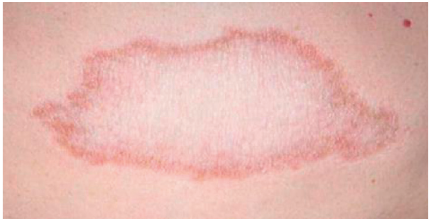
Figure 2: Tuberculoid leprosy: lesion with a single, stable, hairless plaque, and well-defined borders (photograph courtesy of Eichelmann, et al.) [23].